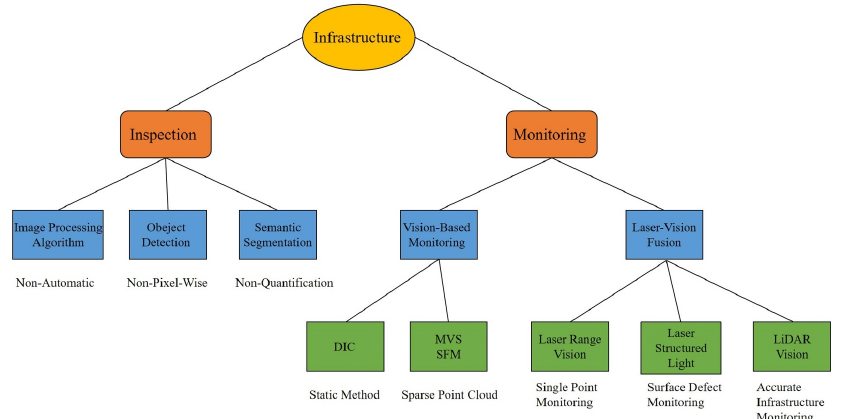
Figure 1. Workflow performed in this review paper.